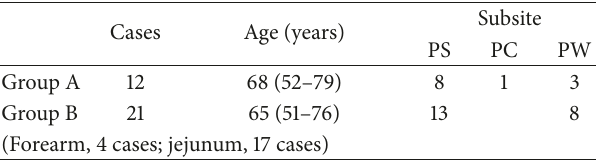
Table 1: Distribution of patients.